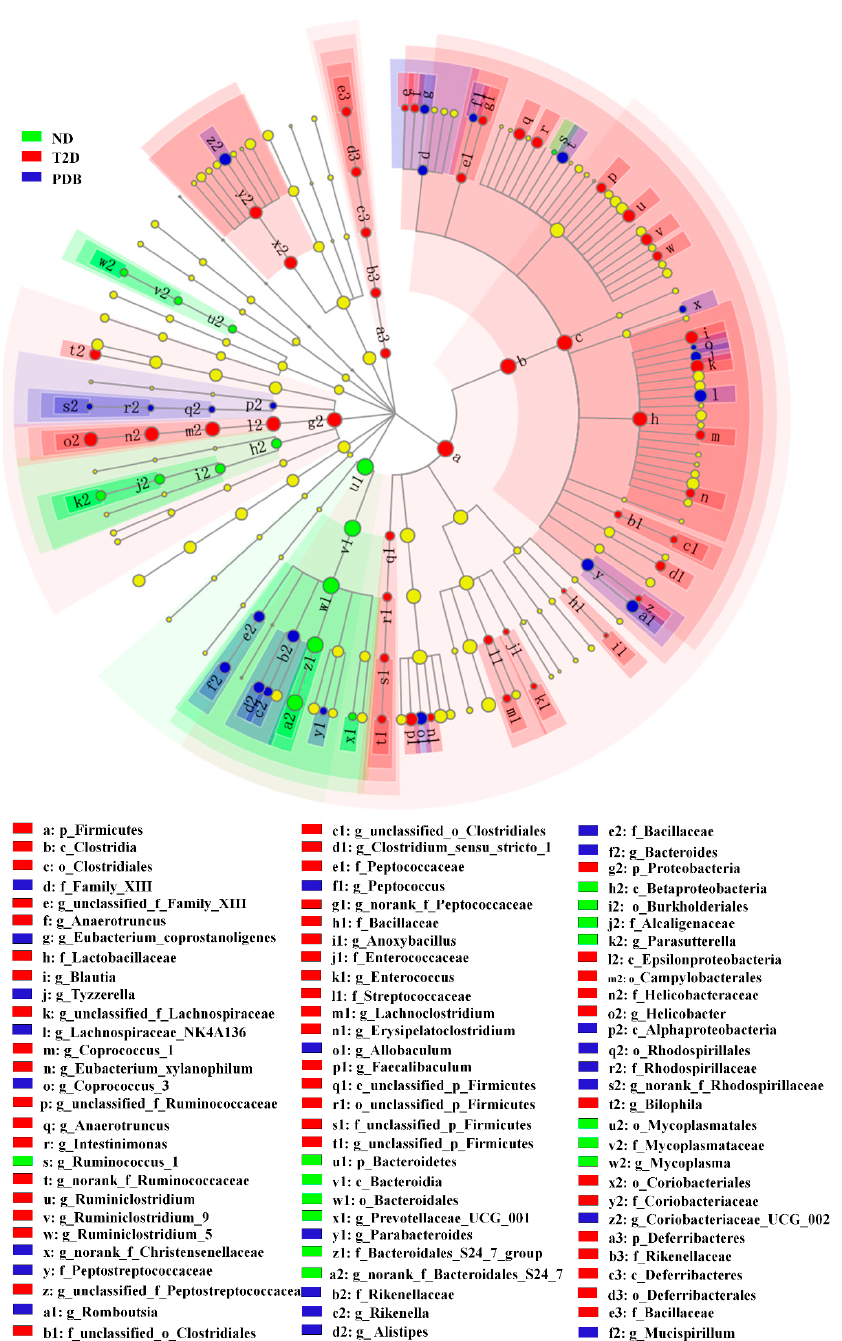
Figure 5. PDB intervention modulated taxonomic diversity of gut microbiota in diabetic mice. The cladogram showed gut bacterial taxa with a linear discriminant analysis (LDA) score > 3.0. There were six mice in each